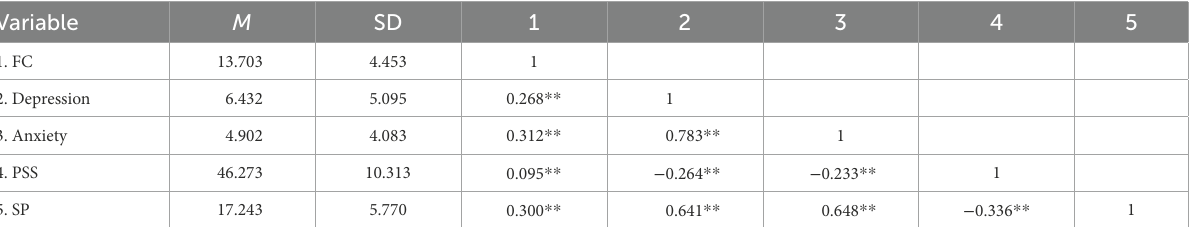
TABLE 3 Mean, standard deviation, and correlation analysis results of each